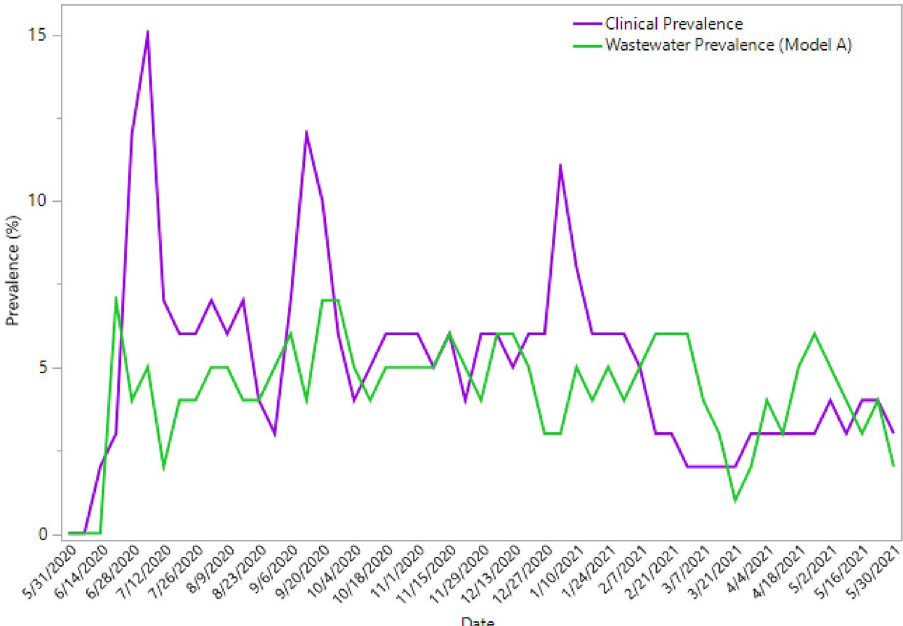
Figure 4. Estimated COVID-19 prevalence estimates between May 26, 2020 and May 30, 2021 in Gainesville, FL. The COVID-19 clinical prevalence is derived from the FL DOH weekly test positivity rate and the Model A ( I = 8.9 Log 10 GC/g feces) wastewater prevalence was calculated by using the mass balance